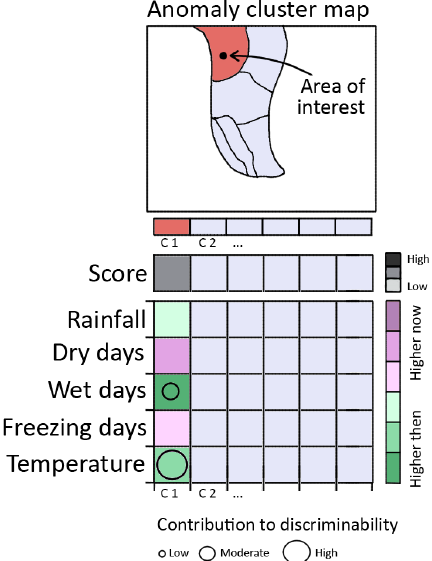
Figure 2. Example problem: investigating how climatic boundary conditions for erosion processes have changed in a specific region of interest involves consultation of part of the conceptualised results figure. The location of the region of interest geographically coin- cides with the region assigned to cluster C 1 . Consequently, only the results related to C 1 are consulted and the rest is greyed out. The clusters were calculated from the differences in the values (delta values) of geomorphically relevant climate variables between two different times ( T 1 and T 2) in the Late Cenozoic and thus repre- sent a specific mode of change. The mode of change associated with the cluster of interest ( C 1 ) is revealed by the purple–green column. The relative contributions of the delta values to the overall discrim- inability between T 1 and T 2 in cluster C 1 , indicated by the score, is revealed by the diameters of the circle superimposed onto the delta values in the purple–green